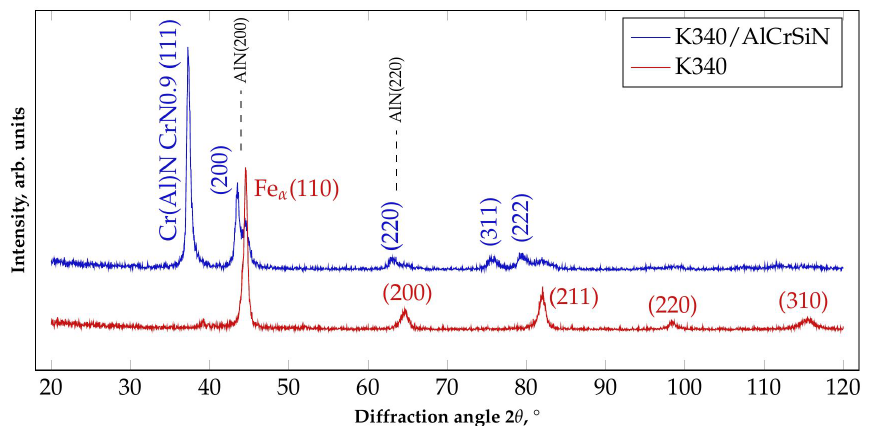
Figure 3. X-ray diffraction (XRD) pattern of the K340 sample in as-received condition and after AlCrSiN coating deposition.